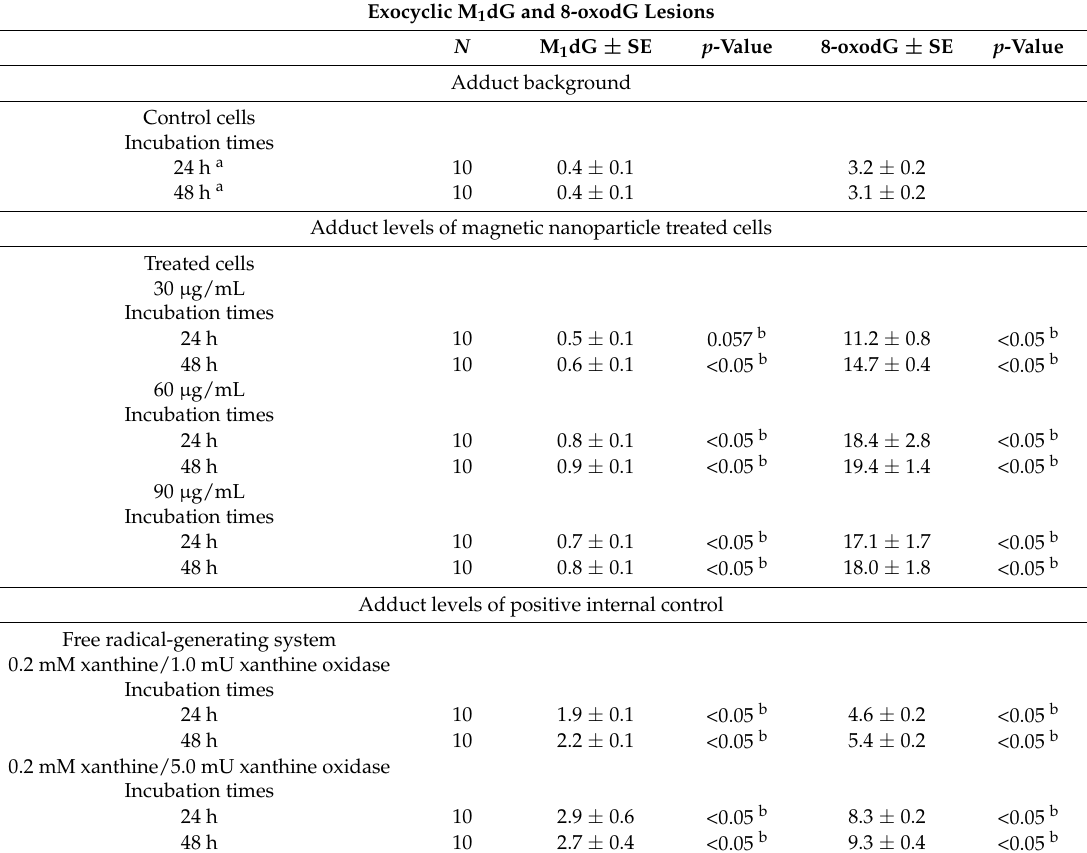
Table 1. Mean levels of 3-(2-deoxy- β - D -erythro-pentafuranosyl)pyrimido[1,2- α ]purin-10(3 H )-one deoxyguanosine (M 1 dG) adducts and 8-hydroxy-2 (cid:48) -deoxyguanosine (8-oxodG) per 10 6 normal nucleotides in HepG2 cells after treatment with 30, 60 or 90 µ g/mL of Fe 3 O 4 -nanoparticles and prolonged incubation times compared to control cells. Adduct levels caused by a free radical-generating system in our model are reported, as positive internal